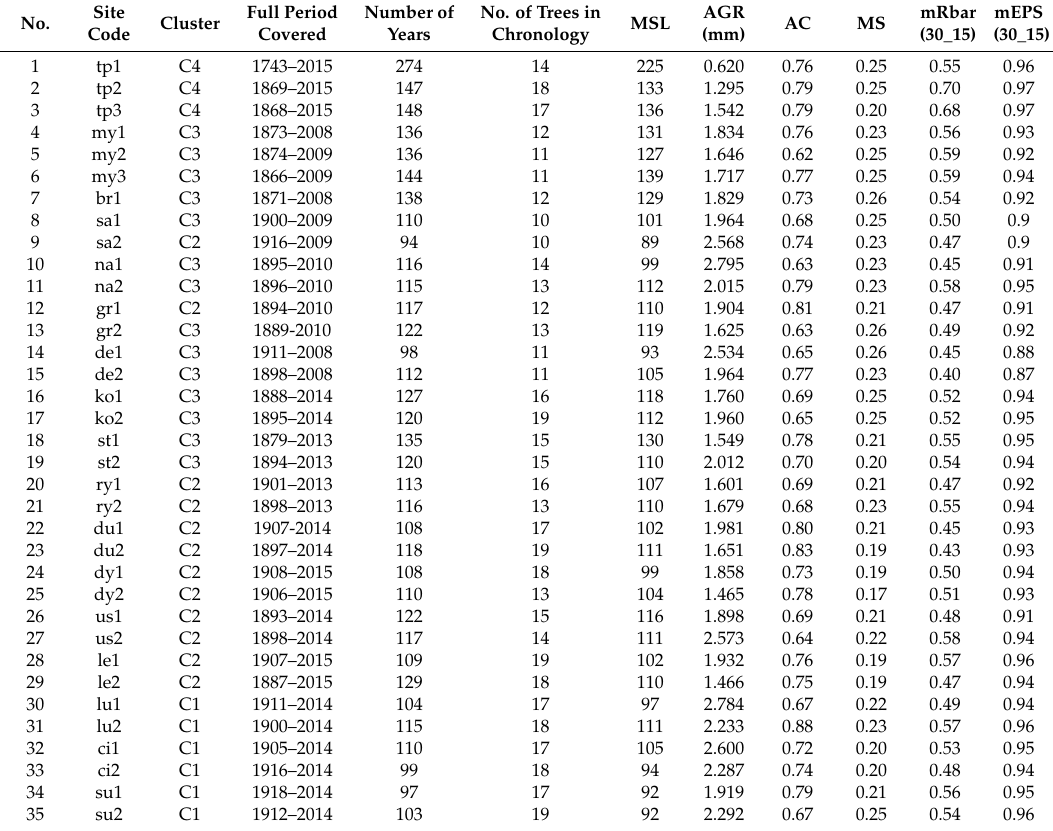
Table 2. Characteristics and descriptive statistics for the constructed